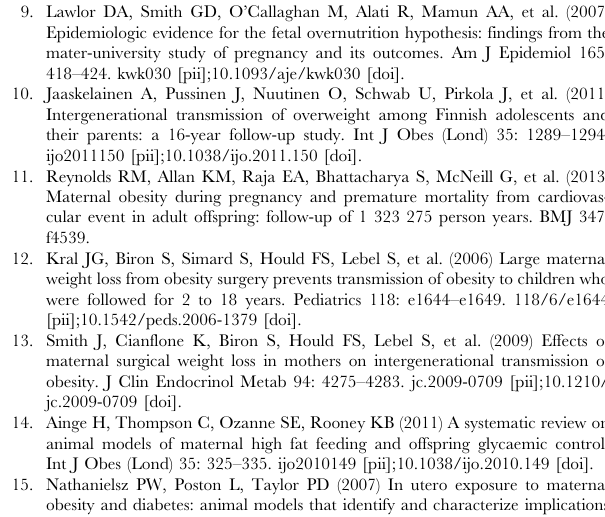
ODS. FIGURE S1. Serum Parameters at 6AM. TABLE S1. Primers Sequences for Real-time RT-PCR Analyses. TABLE S2. Animal Characteristics of Offspring of Lean and Obese Dam Offspring at 6AM. TABLE S3. Model Parameters and Definitions. TABLE S4. Estimated PPAR a Parameter Values. TABLE S5. Most Highly Correlated Model Parameter PRCC